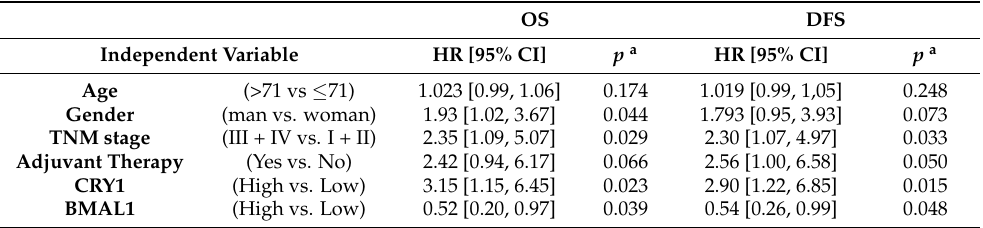
Table 10. Multivariate Cox regression analysis of CRY1 and BMAL1 expression and clinicopathologic variables predicting survival in our cohort of